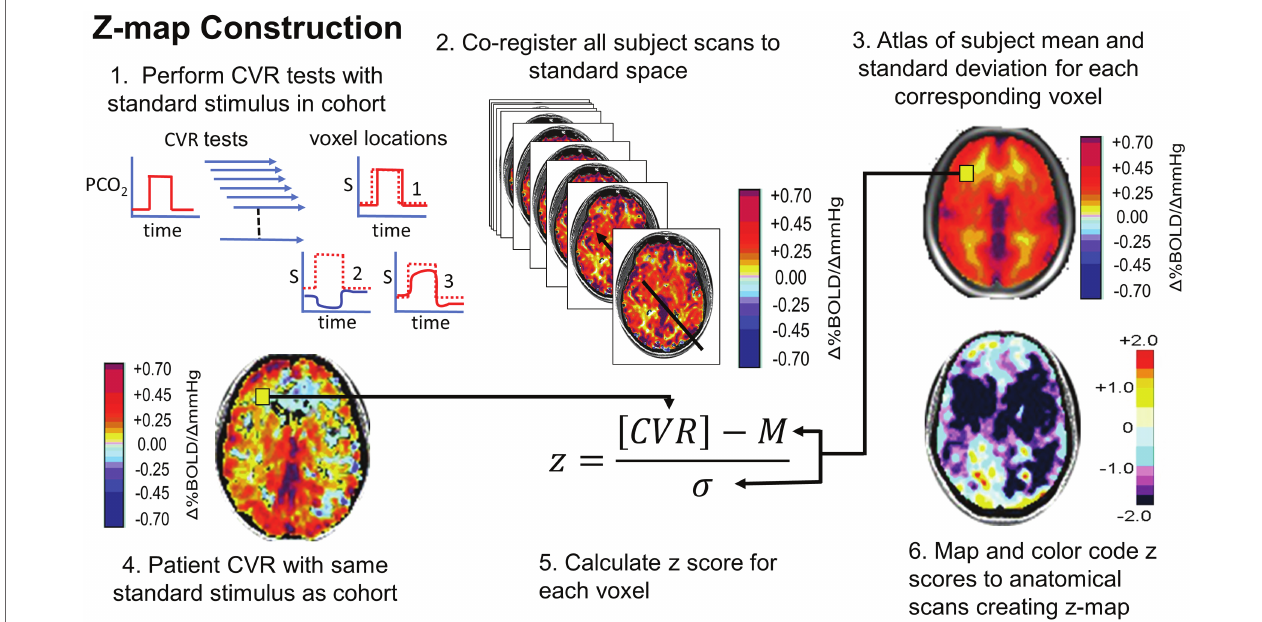
FIGURE 10 | Normalizing the CVR score in terms of the normal range. An identical stimulus is applied to each subject in a cohort of healthy people. CVR is calculated and mapped to standard space. Mean (M) and standard deviation ( σ ) are calculated for each voxel. A patient is administered the same test. The patient CVR is assessed as z-scores, defined as shown in step 5. Z-scores can be color-coded and mapped over the anatomical scan to show the distribution of coherence to the mean. Figure from Fisher et al.